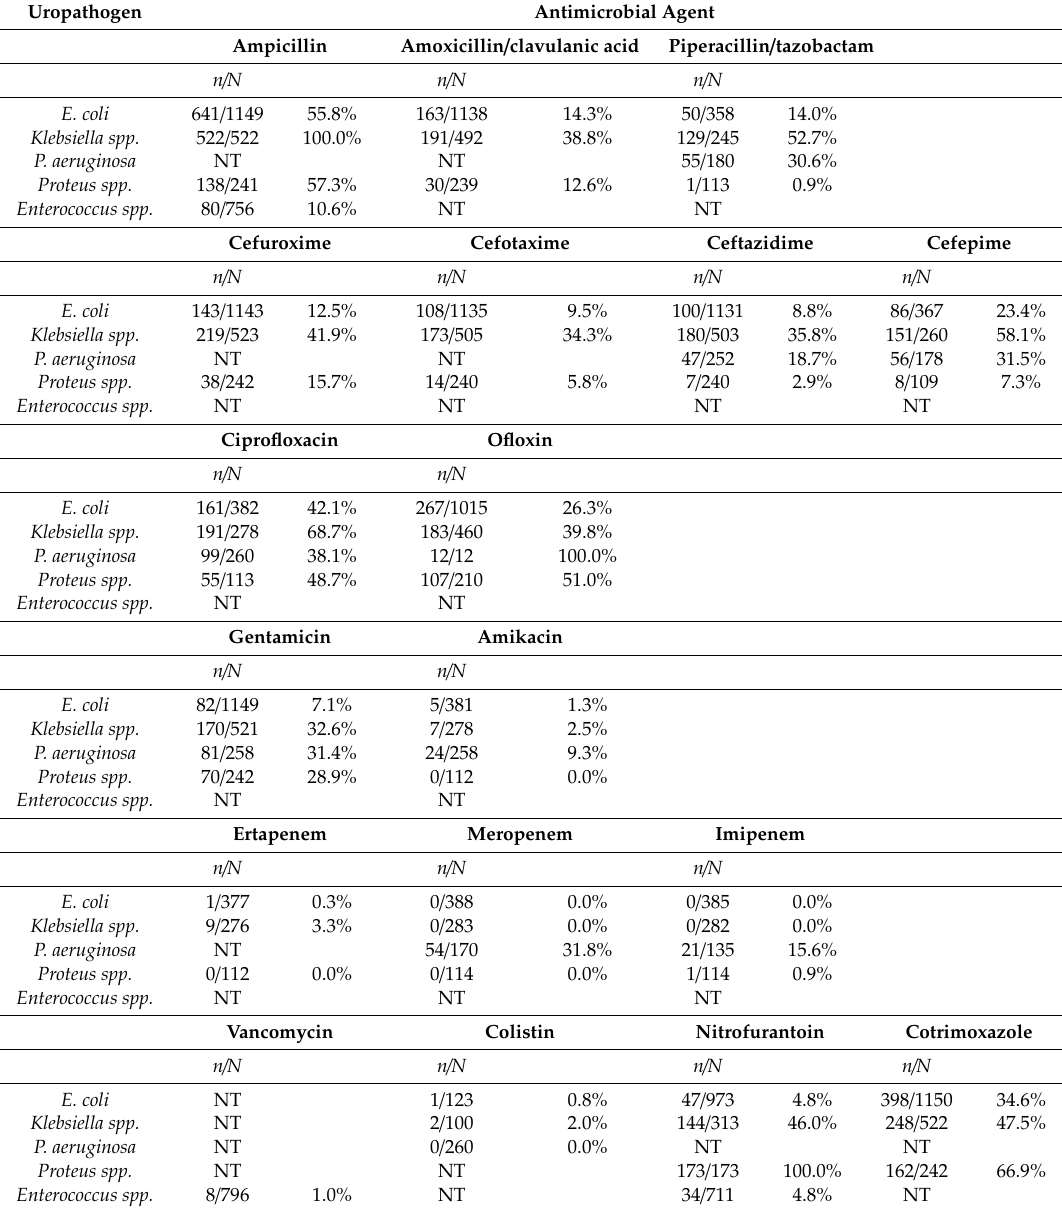
Table1. Cumulativeresistanceratesforindividualuropathogensandantibiotics, respectively, 2011–2019. N, total number of isolates; n, number of resistant isolates; NT, not tested. Percentages represent the rate of resistant